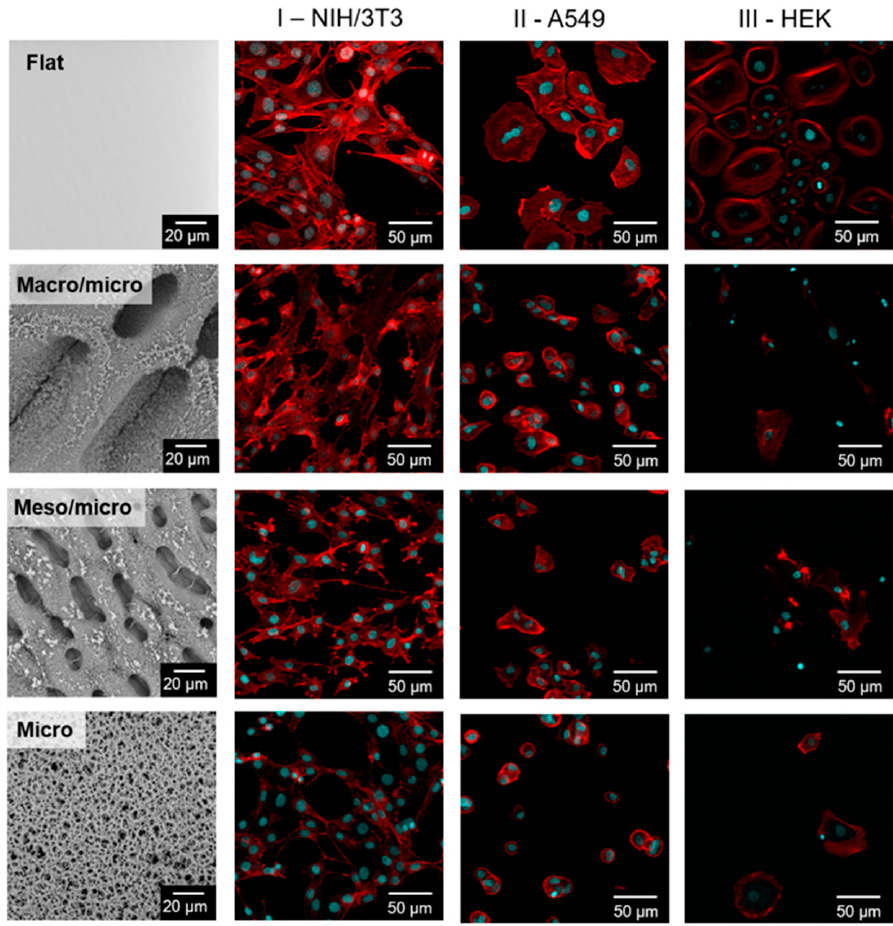
Figure 4. Different cell lines (NIH/3T3 (fibroblasts) column I, A549 (human carcinoma cells) column II and HEK (keratinocytes) column III) on the structured PS. Blue marked cell nuclei (Hoechst), red cytoskeleton (ActinRed). PS surfaces prepared by one or more stepwise time-sequenced phase separation (Macro/Micro and Meso/Micro) correspond to Figure 2. PS foam (Micro) prepared by phase inversion corresponds to Figure 3. SEM images (left), confocal microscope images in the columns I, II,